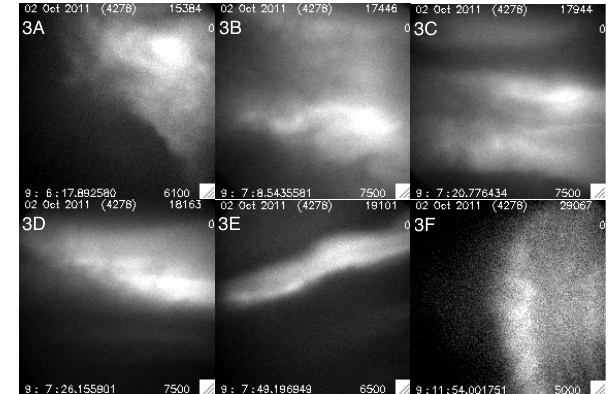
Figure 11. Event 3: narrow-field images (15 ◦ FOV) – taken on 2 October 2011 with a 427.8nm filter – showing the small-scale structure of the aurora at the times of the NEIALs in the PFISR data (labeled 3A–3F). The magnetic zenith – the location of the radar beam ( ∼ 1 ◦ beamwidth) – is located near the center of each image. Same orientation as Fig.